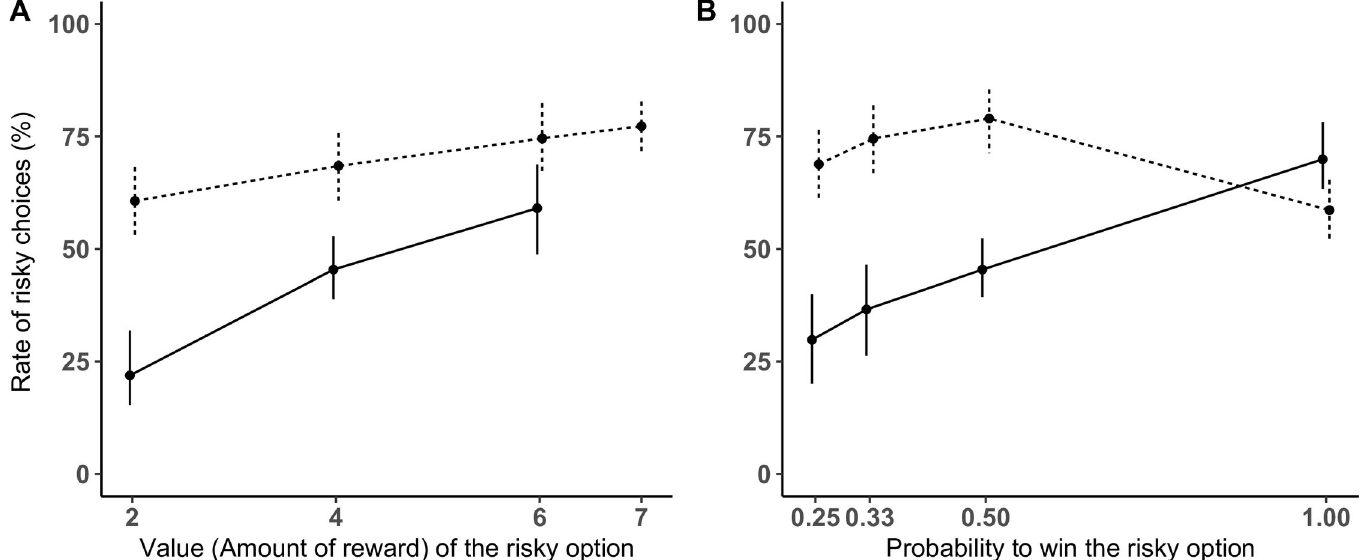
Fig 4. Performance comparison between experiments. Mean percentage of trials where subjects selected the risky option for Experiment 1 (solid line) and Experiment 2 (dotted line, low-valued food type): according to the value of the risky option (A) and the probability to win (B). Error bars indicate 95% confidence intervals.